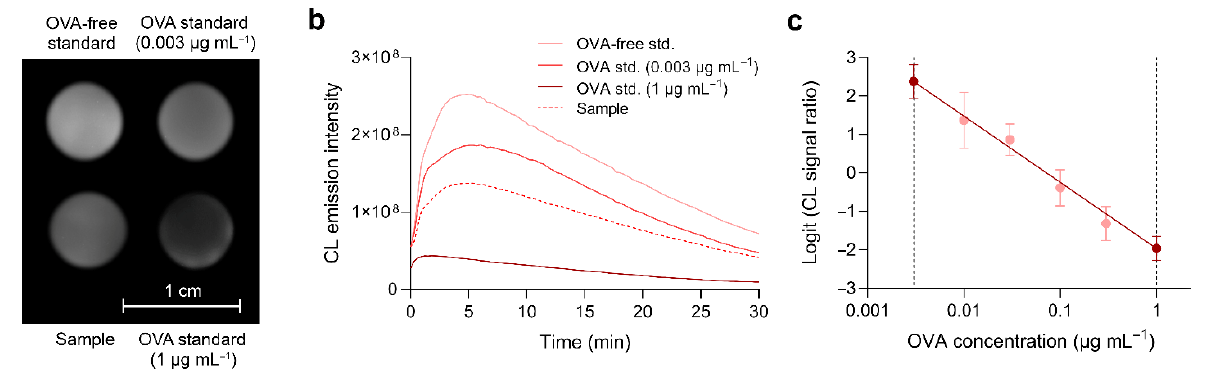
Figure 7. ( a ) CL image of the origami µ PAD acquired during the assay. The scale bar represents 1 cm. ( b ) CL emission intensity kinetic profiles obtained by the analysis of the CL images acquired during the assay. ( c ) Application of the two-standard calibration approach to the calibration data of Figure 6. The readings obtained for concentrations that correspond to the upper and lower limits of the assay working range (dark points) were used to obtain the two-point calibration curve, while the other readings (light points) were simply plotted on the graph.